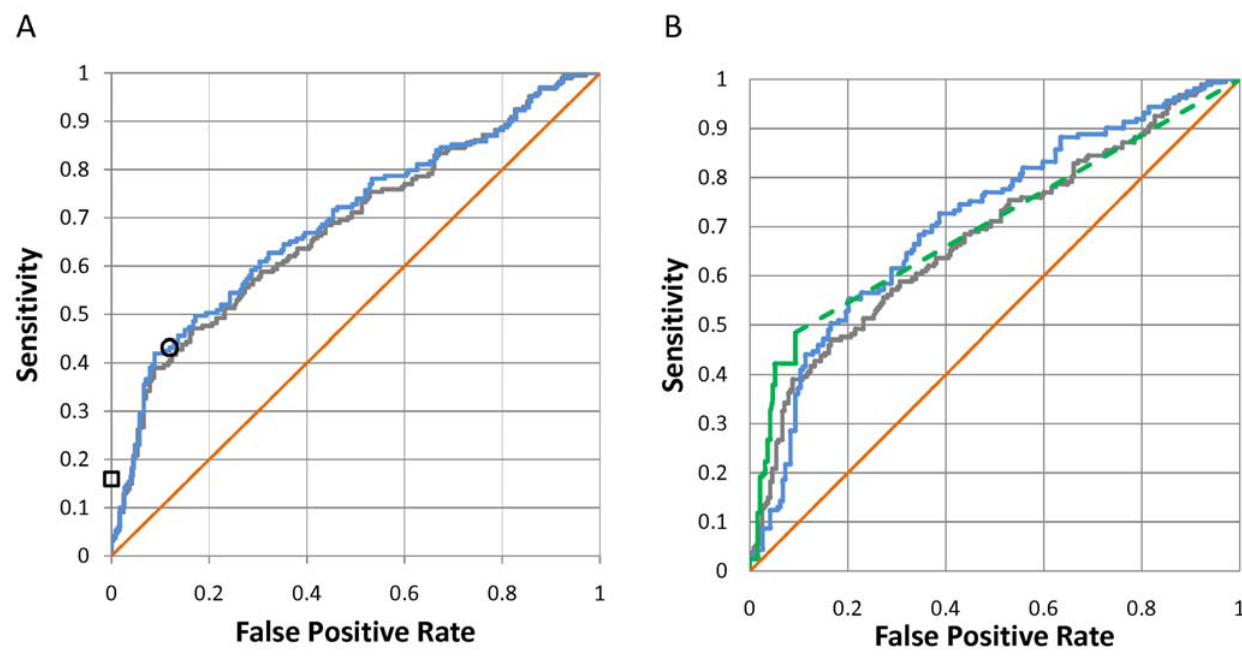
Figure 2. Prediction of SH2 domain-phosphopeptide interactions using FoldX and experimental data from peptide libraries. The orange line corresponds to random prediction, the grey line to prediction for all nine domains in Table 1. (A) Comparison of predictions from experimental consensus sequences allowing zero (square) and one mismatch (circle) with the consensus sequence with FoldX predictions for the eight domains in Table 1 for which a consensus sequence is available (blue line). (B) Comparison of predictions from Scansite scoring matrices for the